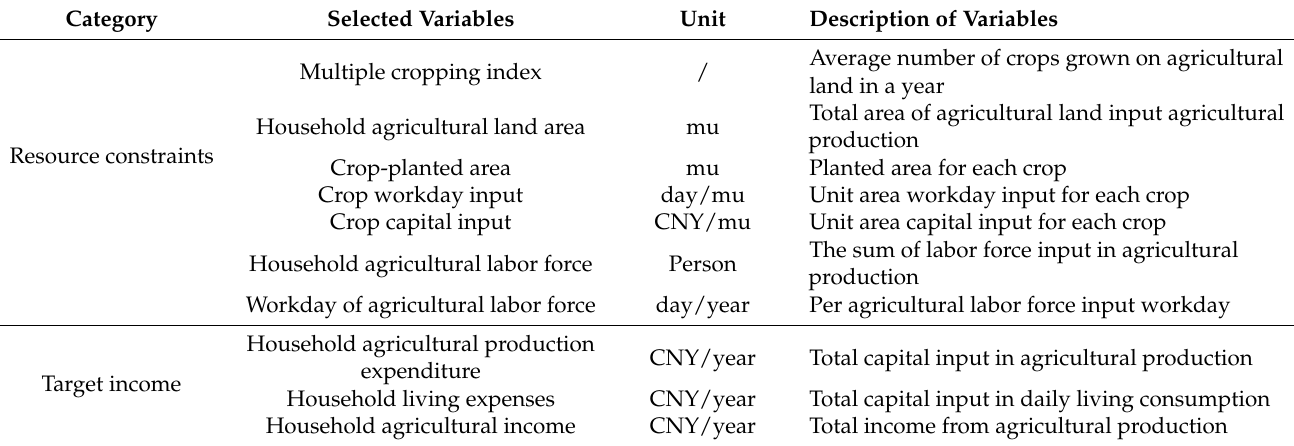
Table 2. Description of selected variables for Target MOTAD